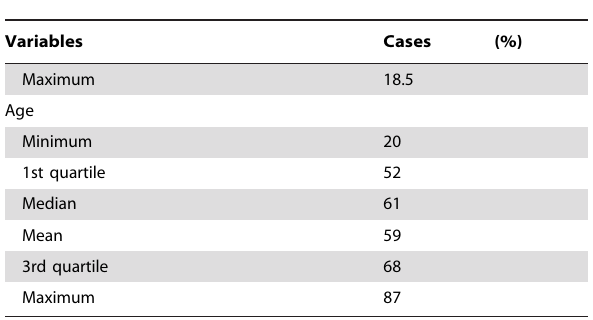
Table 1. Patient demographic and clinicopathologic characteristics for gastric cancer cohort.